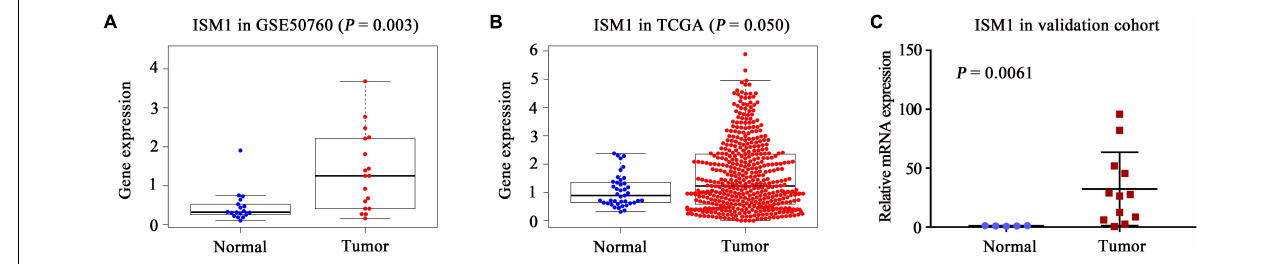
FIGURE 1 | Landscape of ISM1 expression changes. Analysis of differential ISM1 expression between CRC tissues and normal tissues was performed in the (A) GSE50760 dataset, (B) TCGA dataset, and (C) validation cohort.